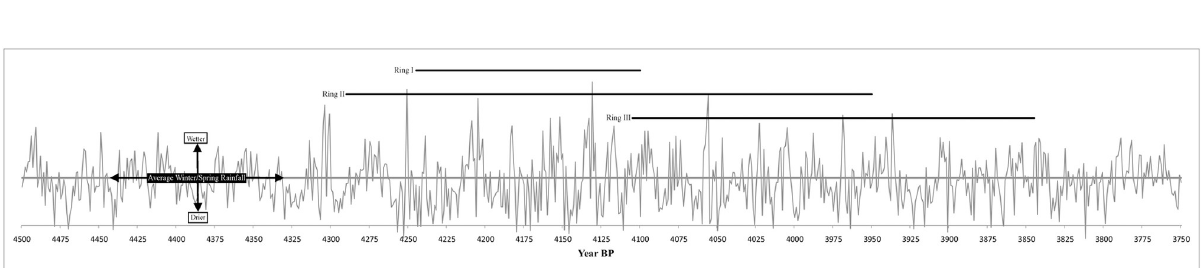
Fig 5. Temporally relevant portion of the multimillennial tree-ring chronology derived from a deposit of ancient buried bald cypress trees at the mouth of the Altamaha River. The chronology is in indices (standardized units representing average ring width, largely indicative in this locale of winter-spring precipitation), with “1000” indicating an annual ring of average width. Enhanced interannual rainfall variability and numerous very dry years are evident beginning around the earliest occupation of Ring I.